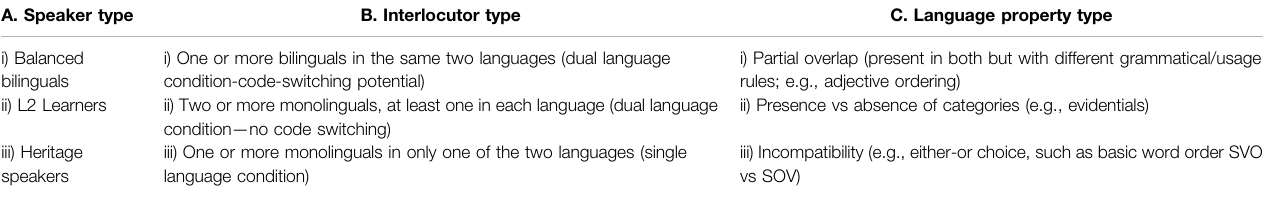
TABLE 1 | Multiple factors in